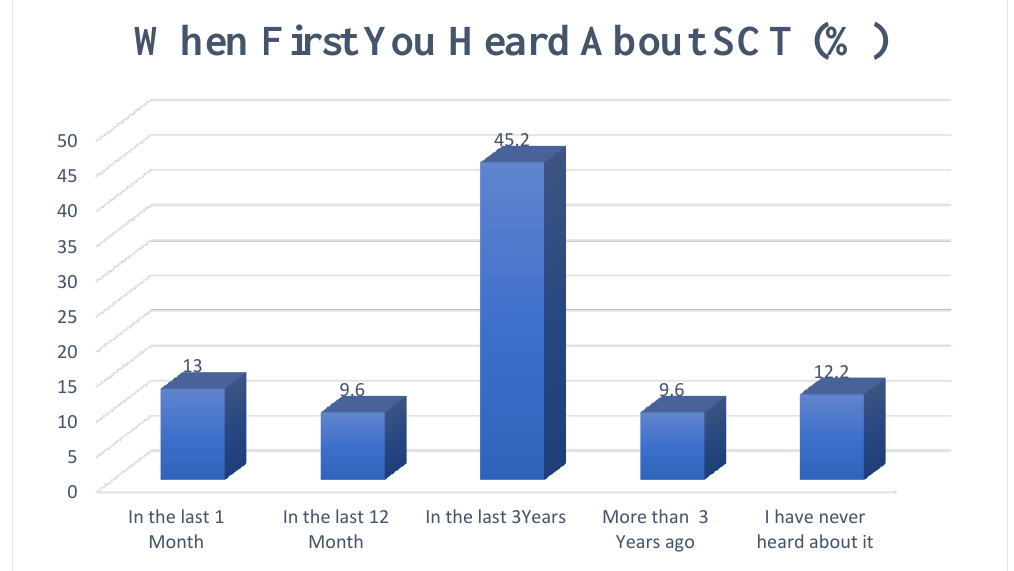
Figure 2. Period of time when SCT was first heard.